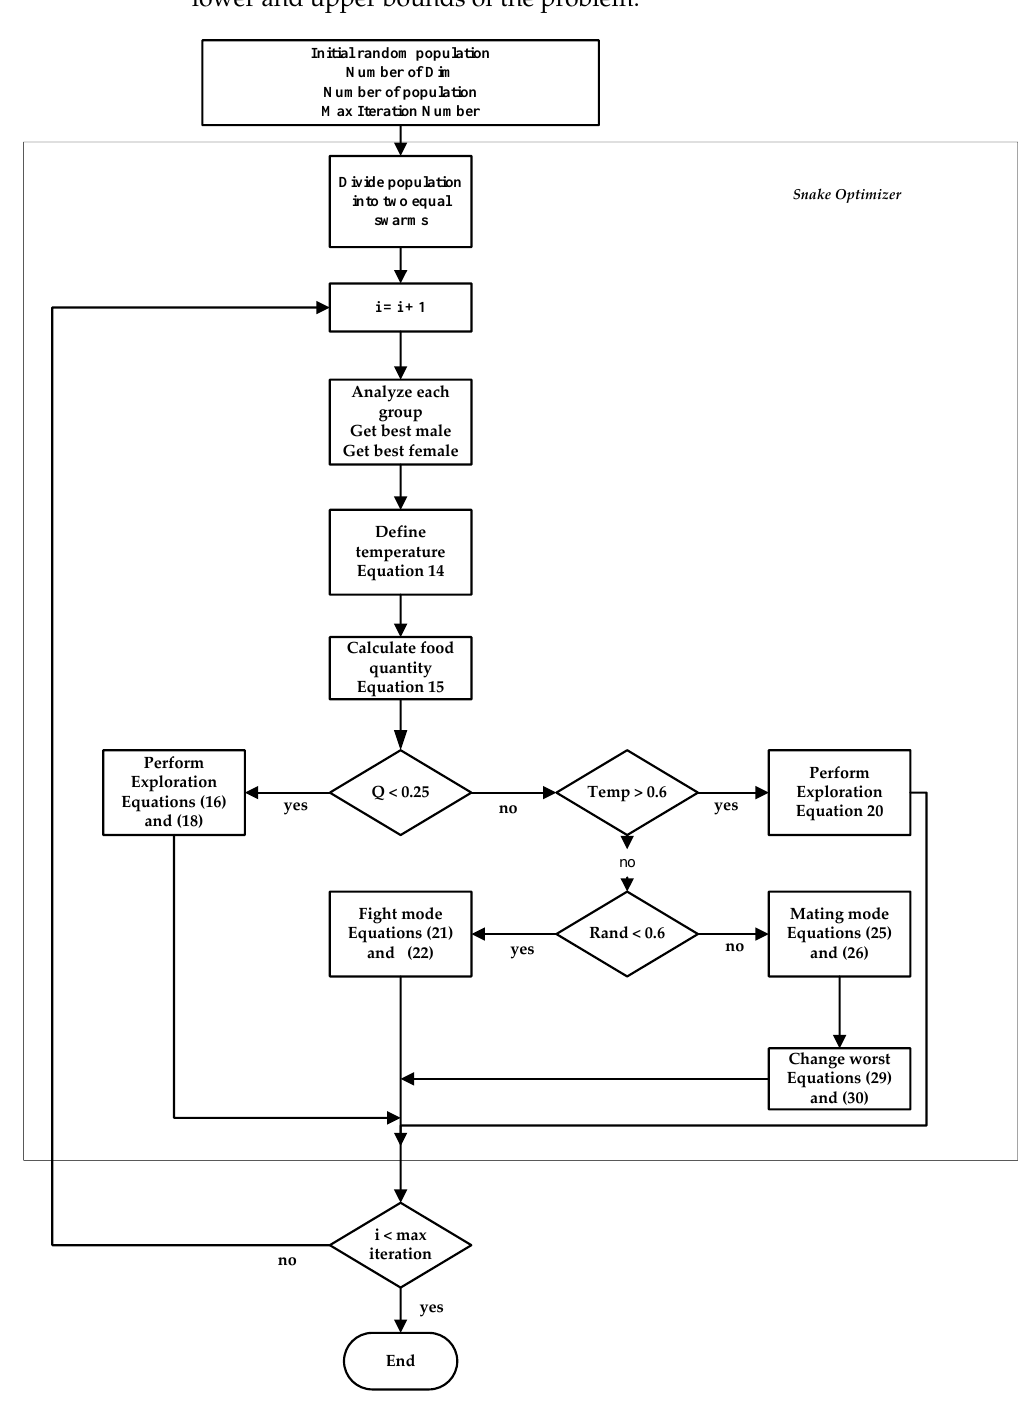
Figure 4. Snake optimization model flow.